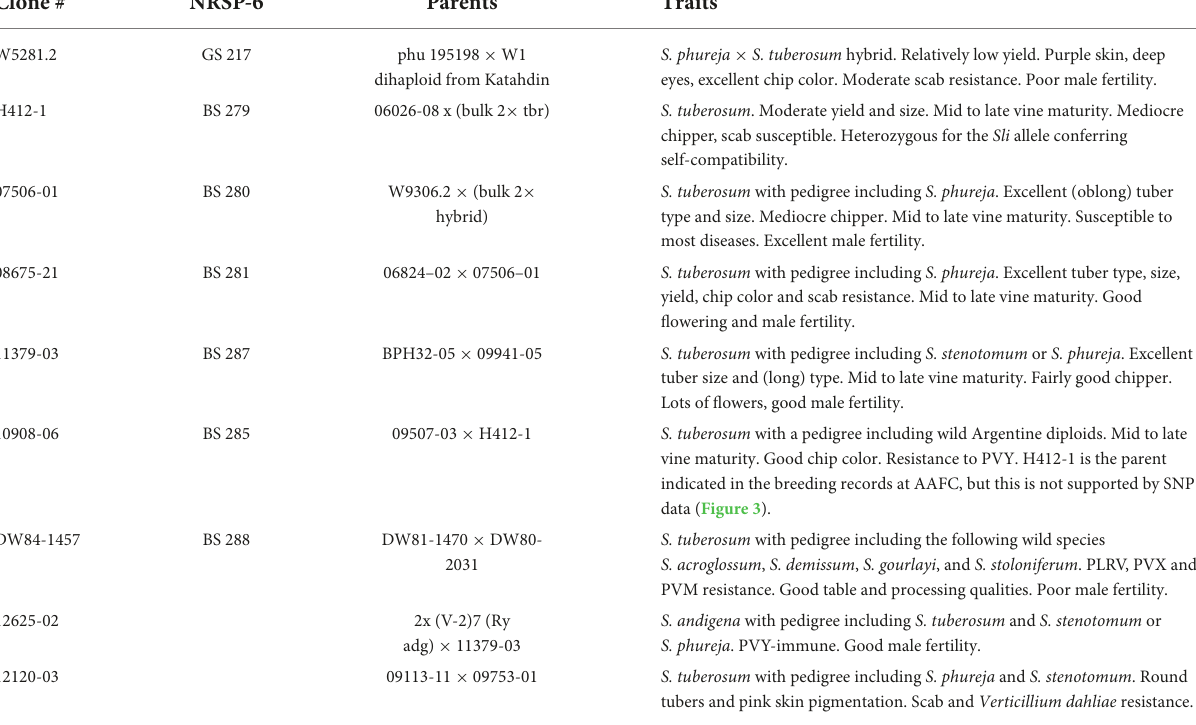
Clone # NRSP-6 Parents Traits